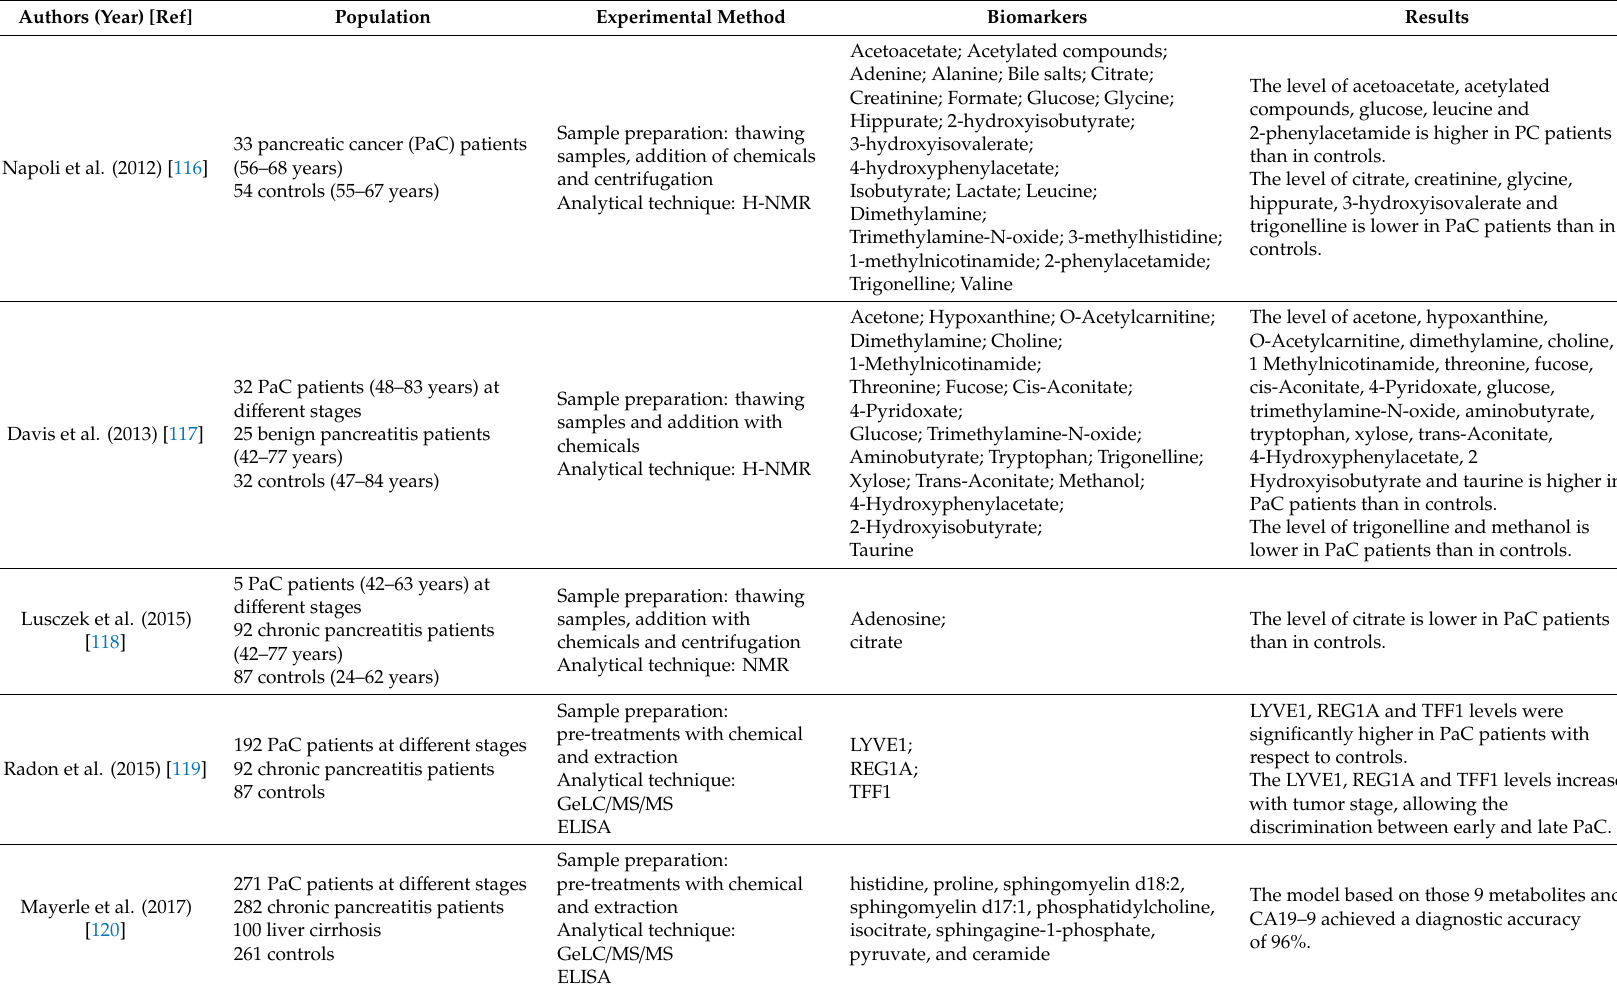
Table 8. Literary studies investigating urinary pancreatic cancer